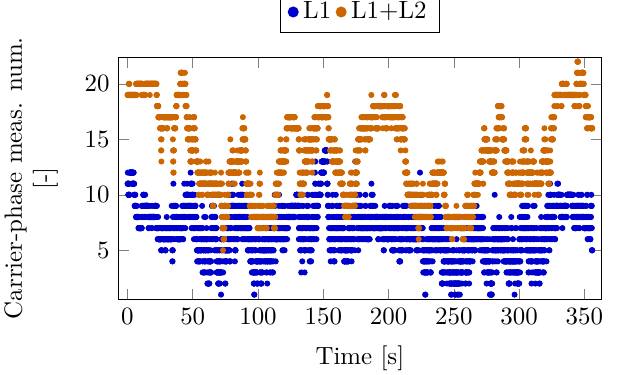
Figure 9. Carrier-phase measurement number—Case Study 2.